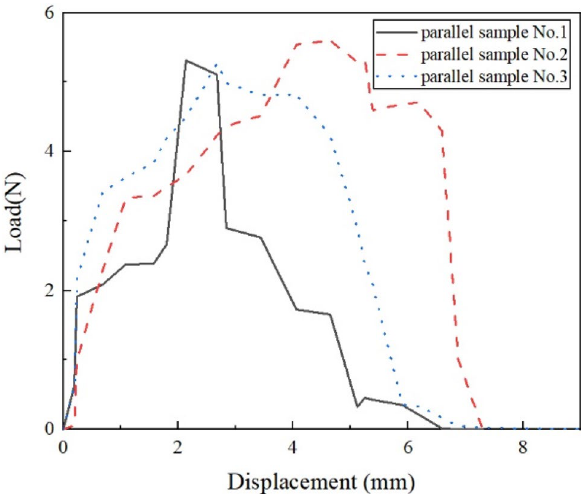
Figure 7. pullout load–displacement curves of the fiber in clay.